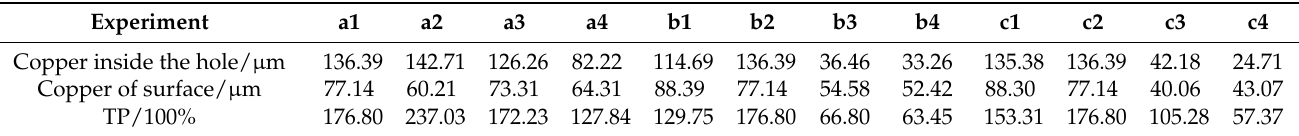
Table 2. The thickness of copper and the TP